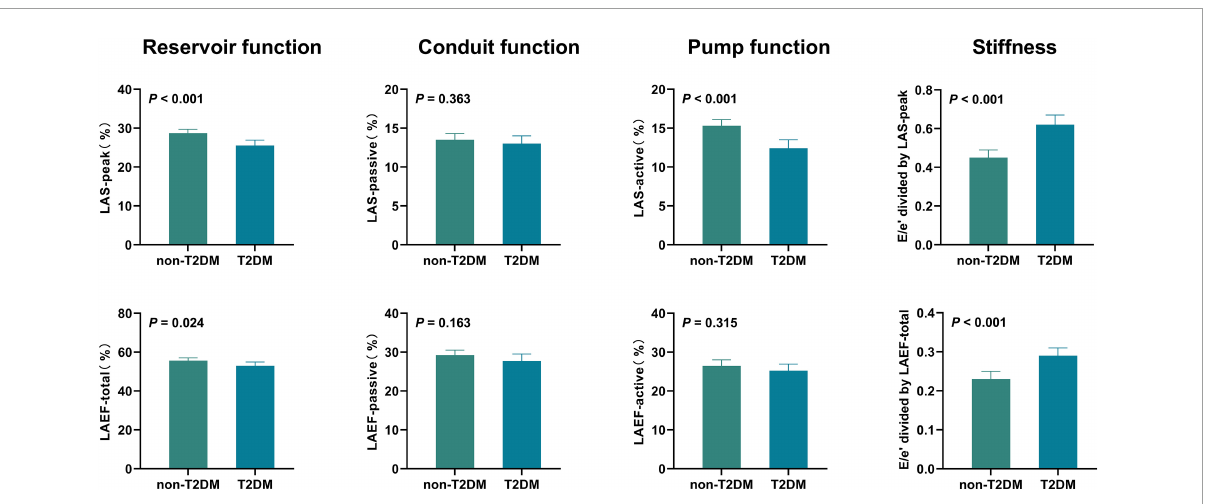
reproducibility, as reflected by high ICC.